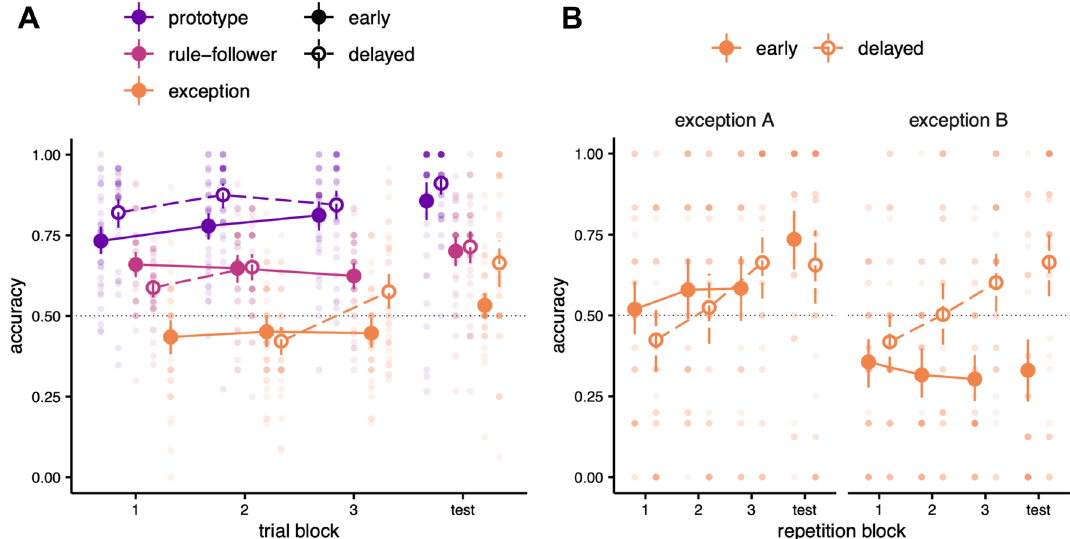
Figure 2. Categorization accuracy in the behavioural experiment. ( A ) Results from the three learning blocks (48 trials total per block) and the test block (48 trials total) for all stimuli. Large points indicate the median of bootstrapped mean accuracies for stimuli in each category across block and condition. Error bars represent bootstrapped 95% confidence intervals. Small dots show average accuracy for individual participants. Categorization accuracy improved more for exceptions in the delayed exceptions condition compared to the early condition. ( B ) Exception results, separated by category. Exception trials have been grouped into blocks of 12 (i.e., repetition block 1 encompasses the first 12 appearances of exceptions in the early or delayed